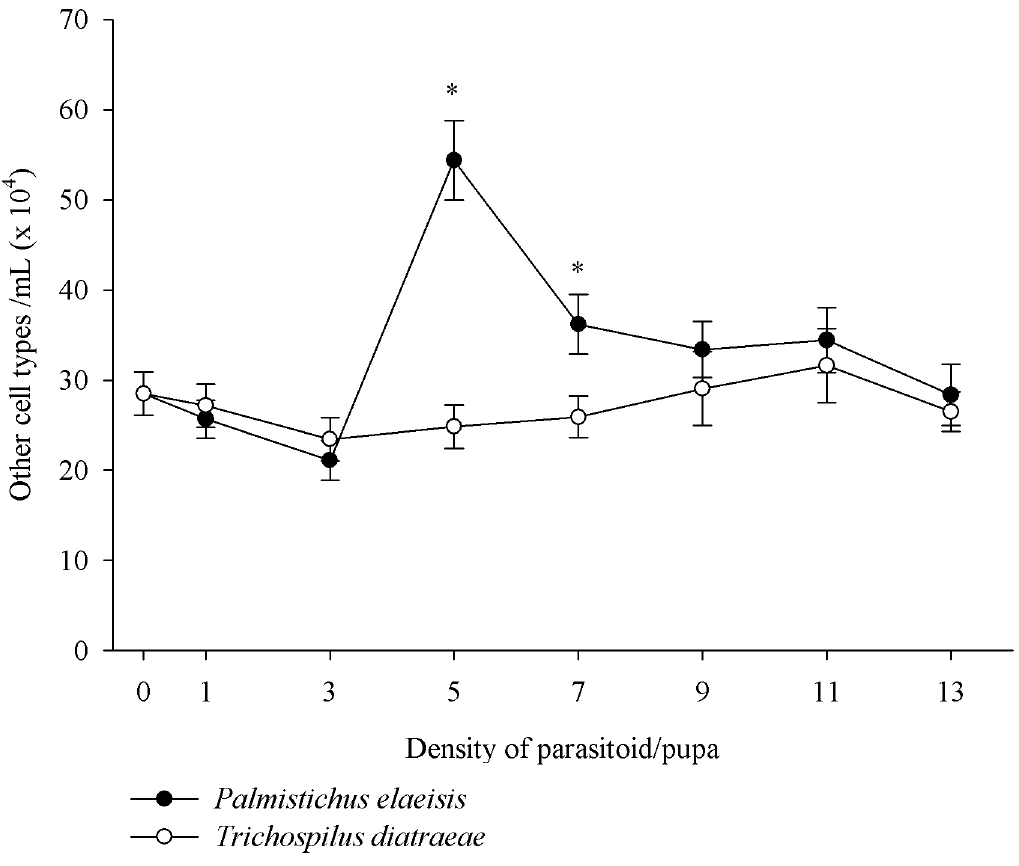
Figure 4. Total of other cell types (mean ± se) of Anticarsiagemmatalis pupae parasitized by densities of Palmistichuselaeisis or Trichospilusdiatraeae .